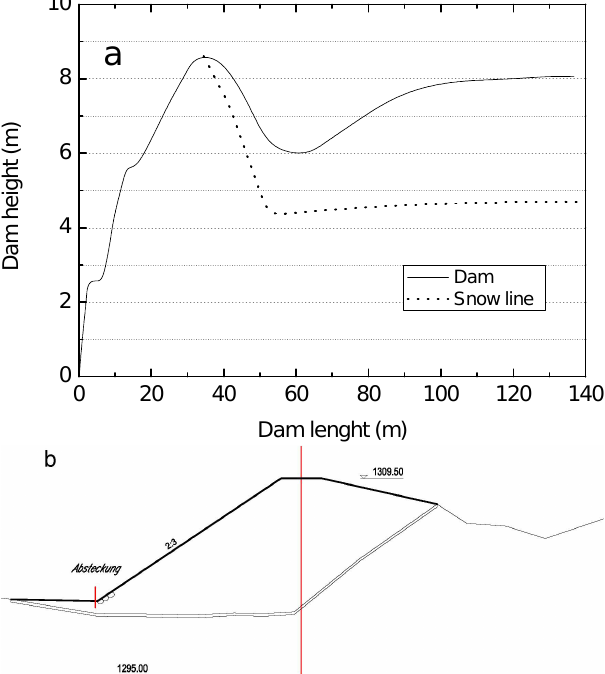
Fig. 3. The Gatschiefer deflecting dam. The upper panel is a sketch of the dam’s longitudinal profile. The avalanche flows from right to left. The dashed line indicates the highest flow mark left by the avalanche of April 2008. The lower panel shows a representative dam section (courtesy of Ing.